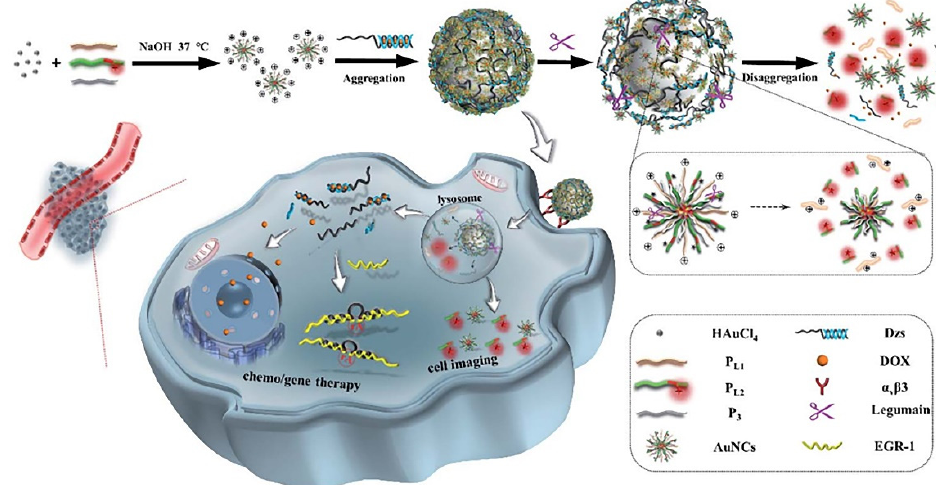
Figure 3. Diagram showing the manufacturing of nanocluster bombs (L-AuNCs/Dzs) and the com- bined use of chemotherapy and gene therapy [87]. combined use of chemotherapy and gene therapy